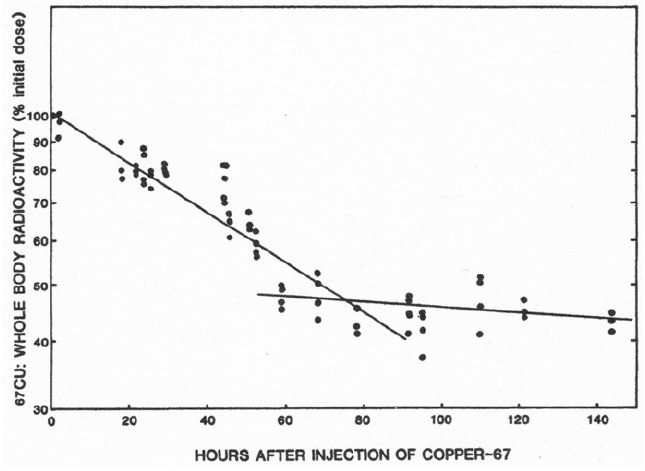
Figure 3. Effect of bile duct ligation on turnover of whole body Cu in rats. Tabulated data on rates of 67 Cu loss in rats where the common bile duct was and was not (sham) ligated prior to 67 Cu administration. Reprinted with permission from Linder, M.C. et al. [2]. * multiplied by 10 6 . ** p < 0.01, *** p < 0.001.